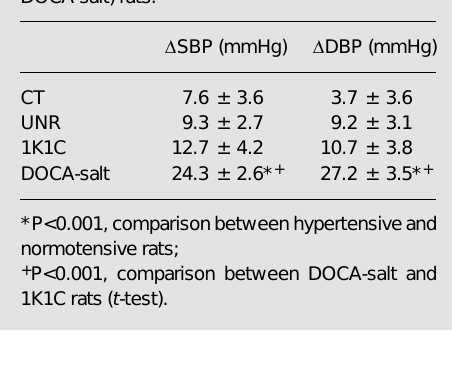
Table 2. Changes in systolic (SBP) and diastolic (DBP) blood pressure before and after 0.18 µg/kg ouabain in normotensive (control, CT; uninephrec- tomized, UNR) and hypertensive (1K1C and DOCA-salt)